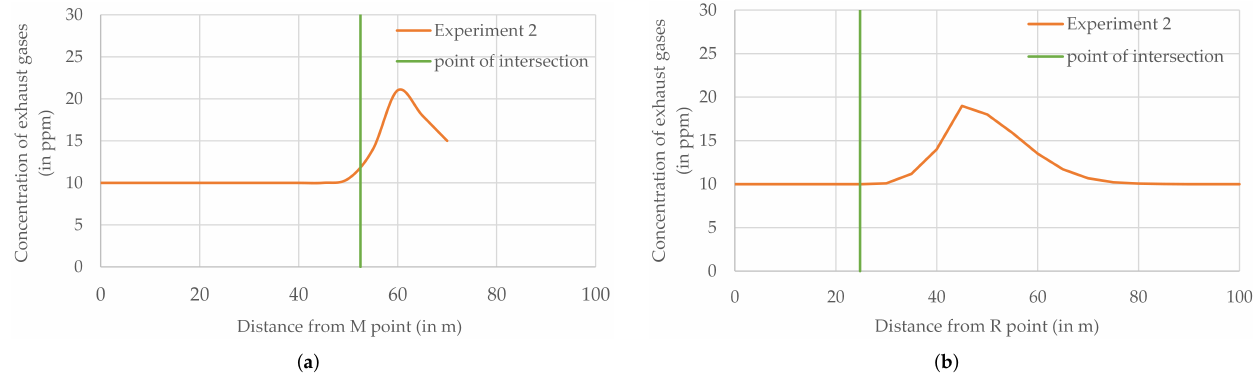
Figure 12. Concentration of exhaust gases (in ppm) during experiment 2 in ( a ) M-N section of flight route; ( b ) R-A section of flight